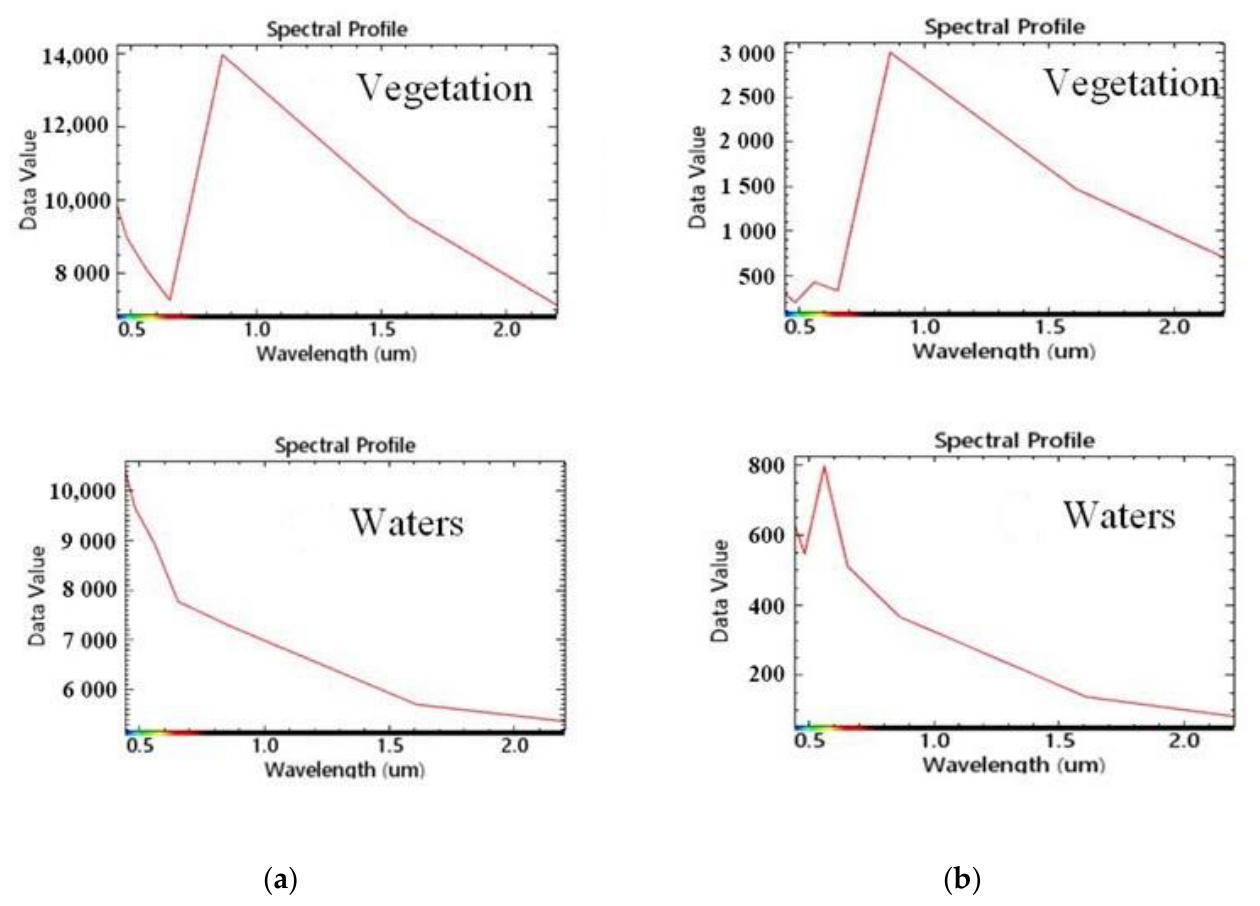
Figure 2. Spectral curves of waters and vegetation: ( a ) before atmospheric correction and ( b ) after atmospheric correction.